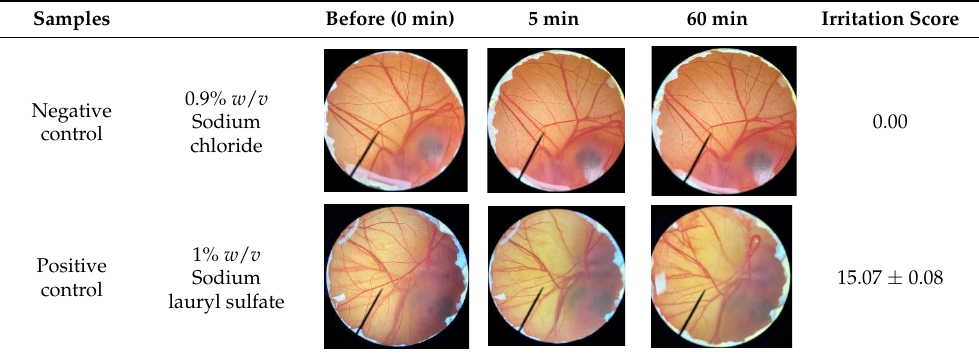
Table 4. Anti-ageing activity of antler-type G. lucidum BG.